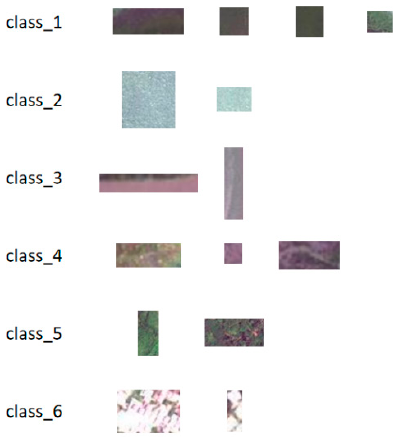
Figure 13. Different categories with classes labeled.